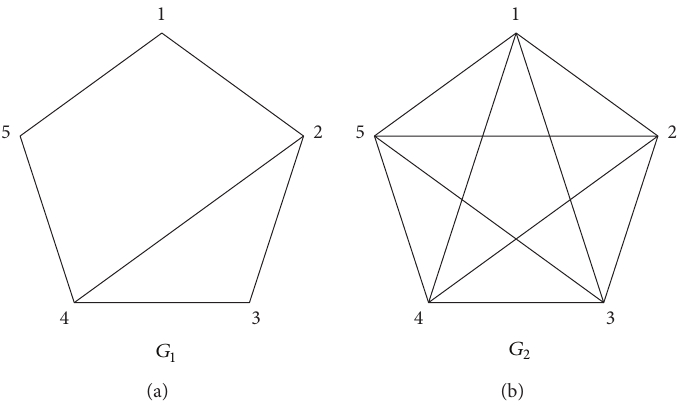
Figure 2: The structure of complex networks with 𝑁 = 5 .